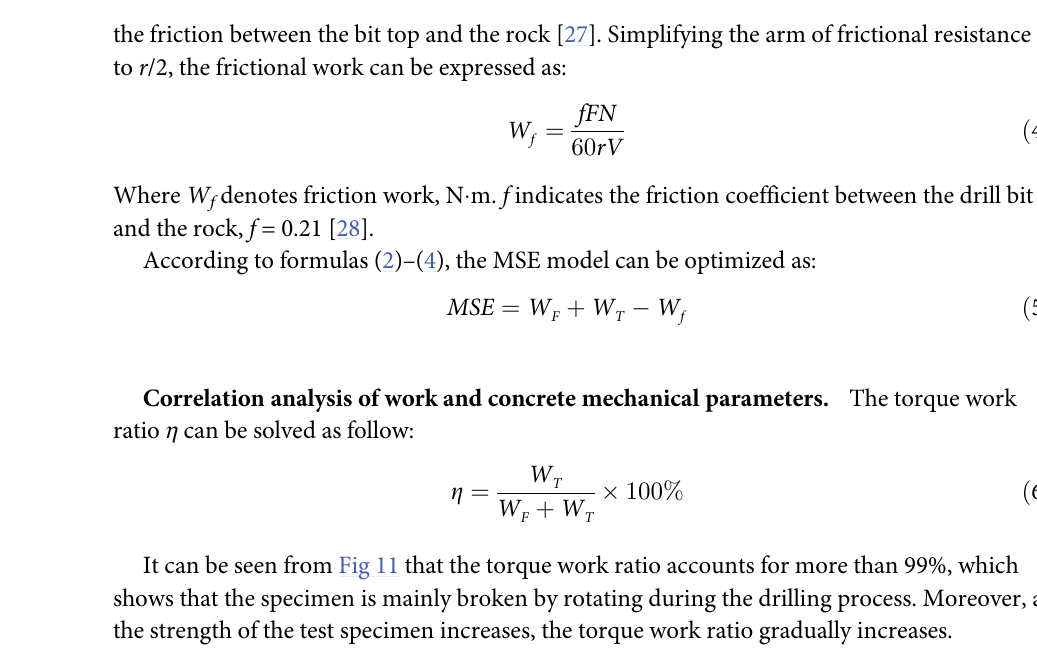
Fig 8. The relationship between rotation speed and concrete mechanical properties. N denotes rotation speed . (a) The relationship between N and UCS. (b) The relationship between N and BTS. (c) The relationship between N and C . (d) The relationship between N and φ . (e) The relationship between N and E . (f) The relationship between N and μ . (g) legend.